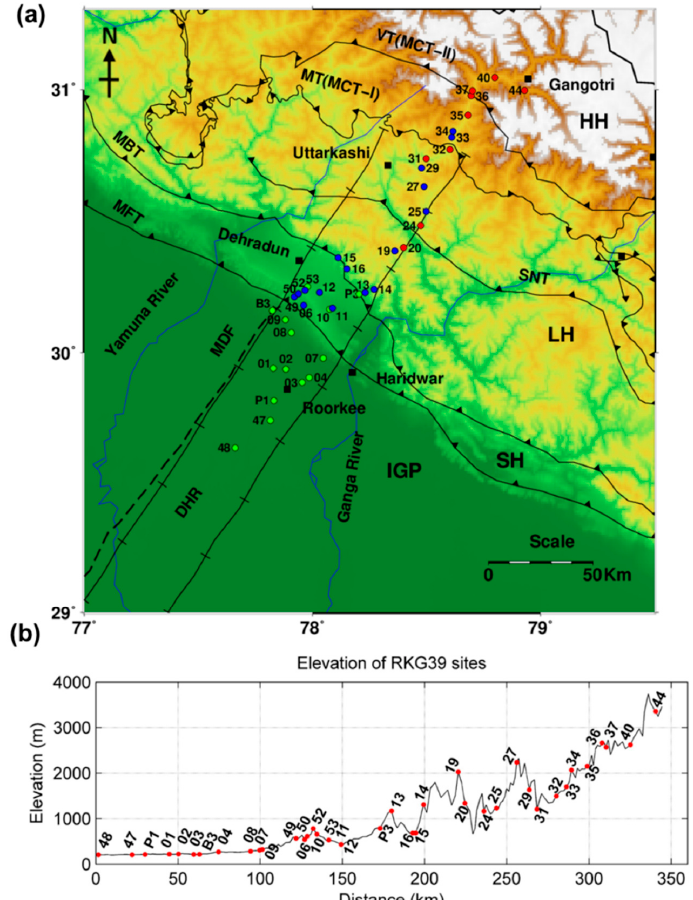
Figure 5. ( a ) Simplified tectonic map of the study area and ( b ) the elevation RG profile along 39 MT sites with a site number. The MT sites are classified by filled colored circles as: the sites with no terrain effects (green), the sites distorted by purely galvanic effect (blue) and the sites distorted by both inductive and galvanic effect (red). HH: Higher Himalaya, LH: Lesser Himalaya, SH: Sub